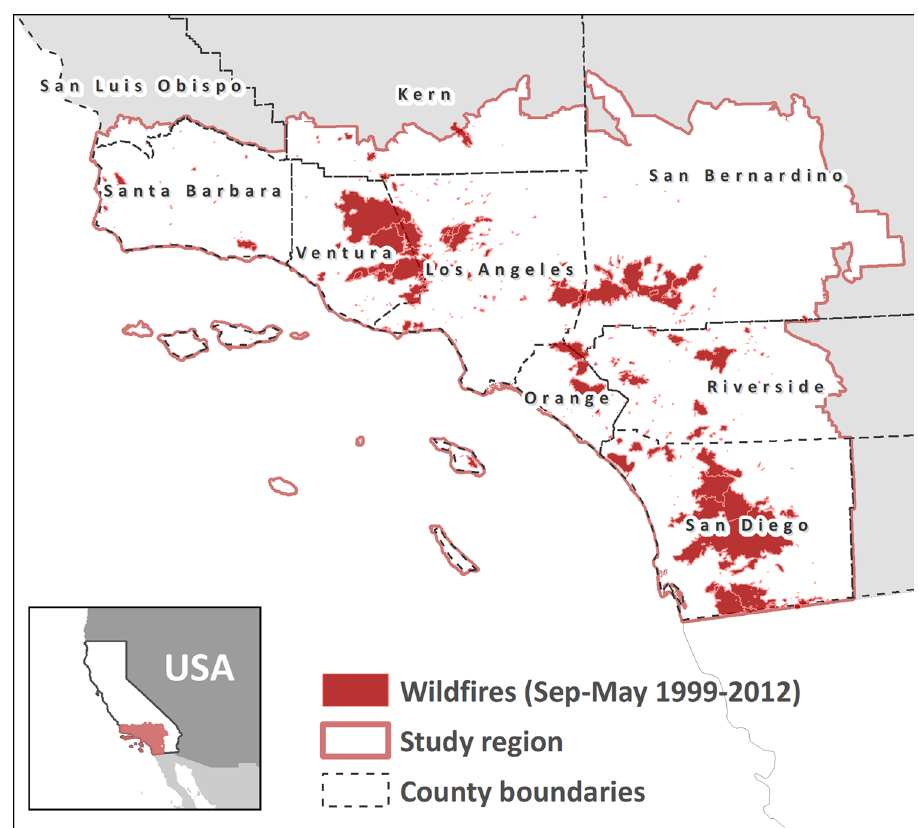
Fig. 1 Wild fi re perimeters in Southern California (1999 – 2012). Wild fi re perimeters shown here represent the total area burned for a given fi re during our study period comprising 1999 – 2012, excluding summer months (June, July, and August). The inset fi gure shows the location of our study region, which includes zip codes within the Santa Ana Wind domain in Southern California, (Fig. S1 in Supplementary information). Figure 3 shows mean values for wild fi re-speci fi c PM 2.5 estimated by imputation and seasonal interpolation, using the fi re upwind and strong SAW